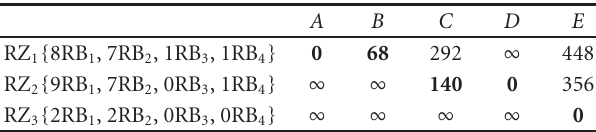
Table 3: RZ types and D